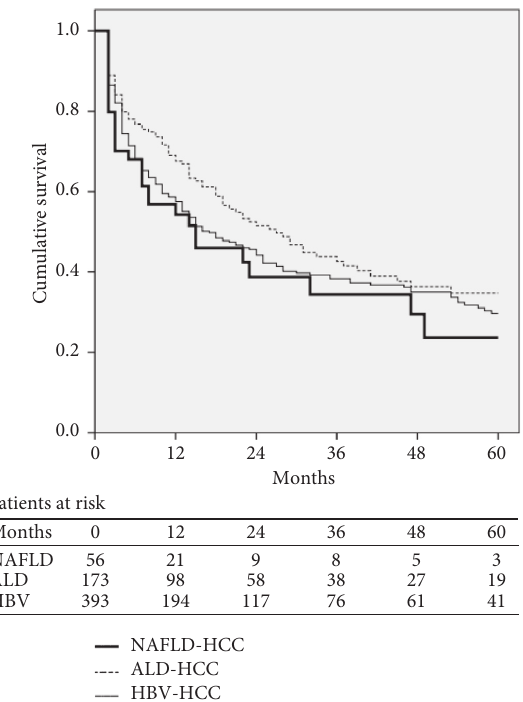
Figure 2: Survival curves of patients with HCC according to underlying etiologies. ALD: alcoholic liver disease; HBV: hepatitis B virus; HCC: hepatocellular carcinoma; NAFLD: nonalcoholic fatty liver